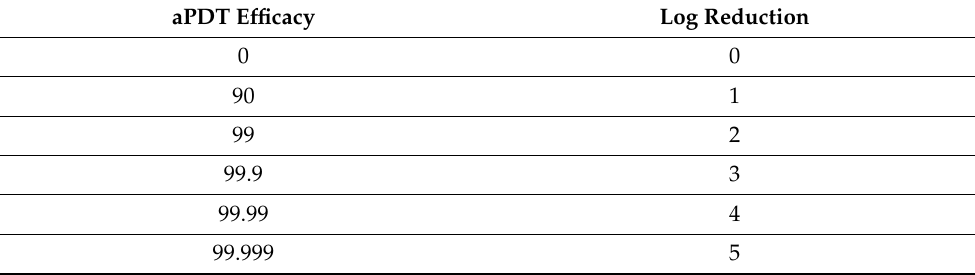
Table 1. Bacteria reduction equivalency chart.